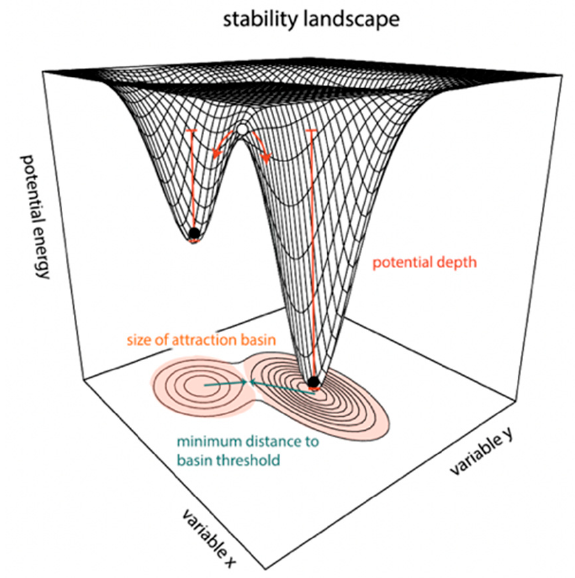
Figure 1. A (hypothetical) stability landscape of a two-dimensional system with hilltops and valleys, also known as a marble-in-a-cup or balls-and-cups landscape. Black balls are found at the bottom of the valley and represent stable states. Retrieved from Dakos and Kefi, 2020 [10] .